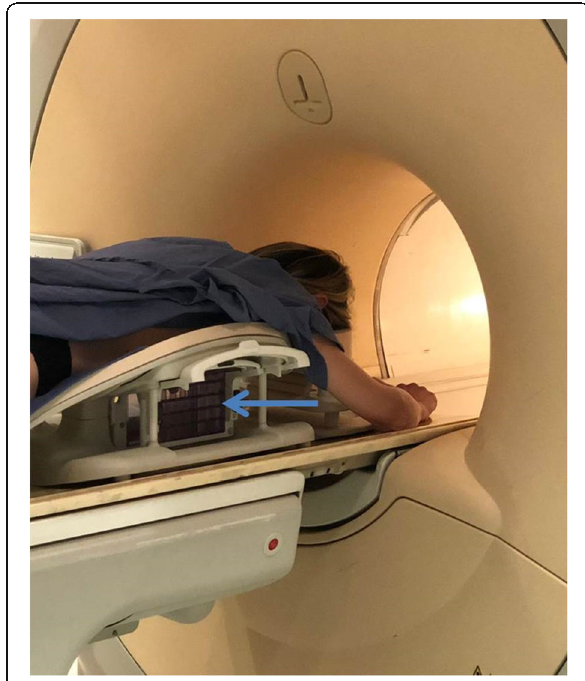
Fig. 4 Magnetic resonance imaging-guided vacuum-assisted biopsy. The patient is prone, positioned on a dedicated coil that allows to insert the needle through a greed (light blue arrow), shown in the figure outside the magnet. After local anaesthesia, the needle is guided to the lesion on the basis of specifically acquired magnetic resonance images. To conclude the procedure, the patient has to enter and exit the magnet at least three times (see